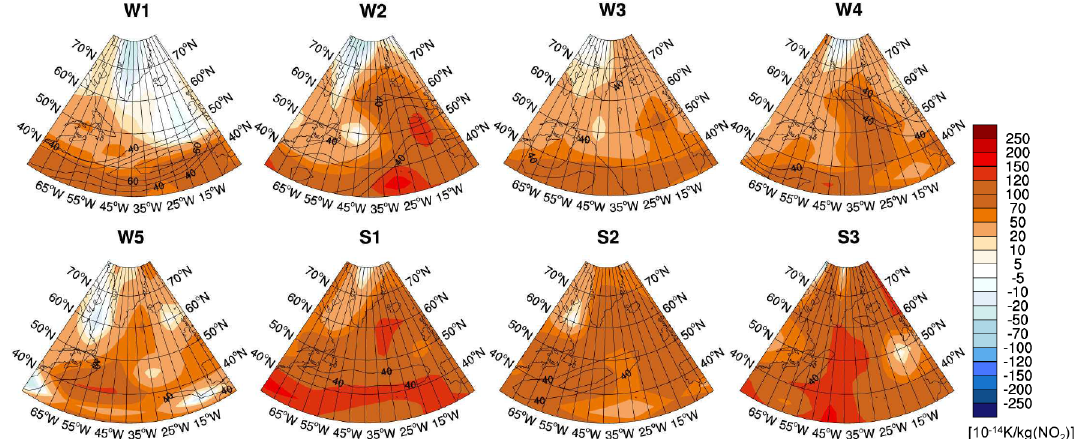
Figure 11. Climate change functions of aviation-induced total NO x (O 3 + CH 4 + PMO) at 250hPa in 10 − 14 K per kilogram of NO 2 for eight representative weather situations and an emission at 12:00UTC. The isolines show the wind speed in metres per second ( > 40ms − 1 ) at 250hPa. CCFs for other pressure levels and times investigated in this study are presented in the